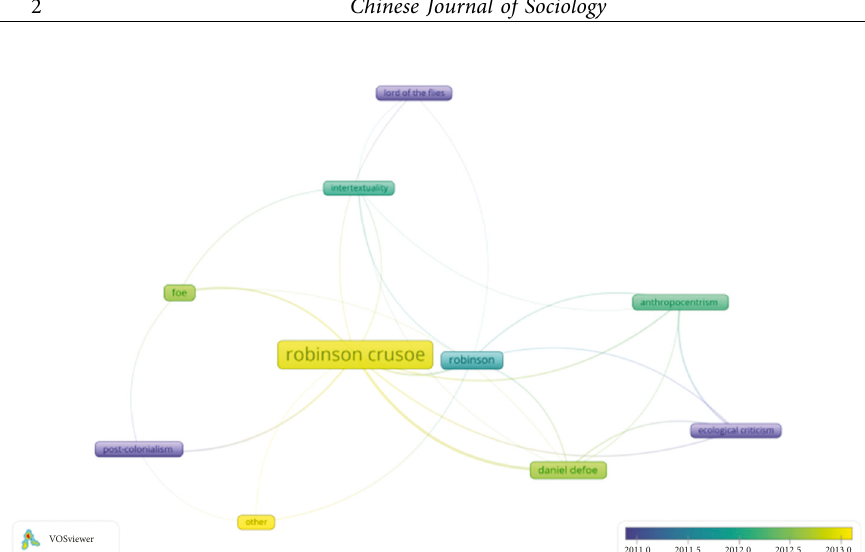
Figure 3: Evolution of the network of keywords based on